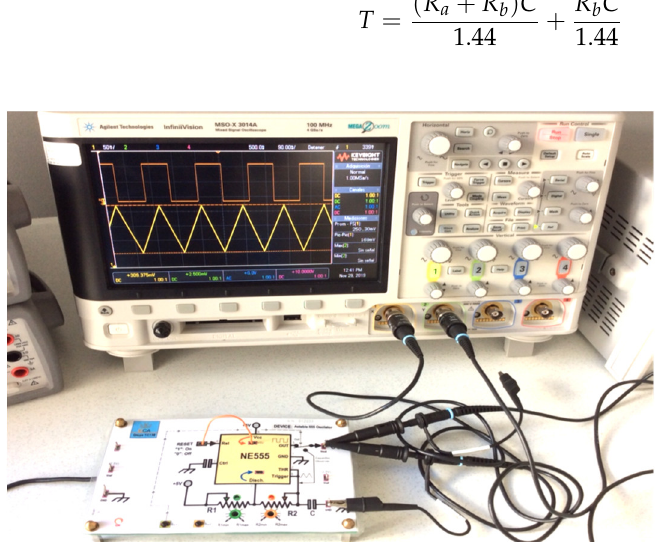
Figure 10. The 555 astable oscillator emulation the oscilloscope shows the square output, and the capacitor charge-discharge (taking advantage of reference channel screen memory).